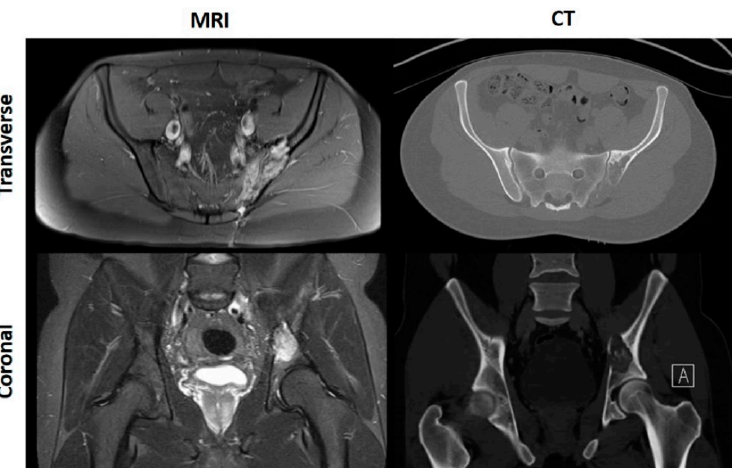
Figure 1. MRI and CT scans of a patient with left sided pelvic OS. PET scans, which are able to detect metabolic activity, are beginning to show immense value within the field of oncology [24–30]. By combining images obtained from the PET scans with CT and MRI images, the metabolic and biochemical activity of the tumour can be overlaid on the anatomical structure to more precisely determine tumour margins